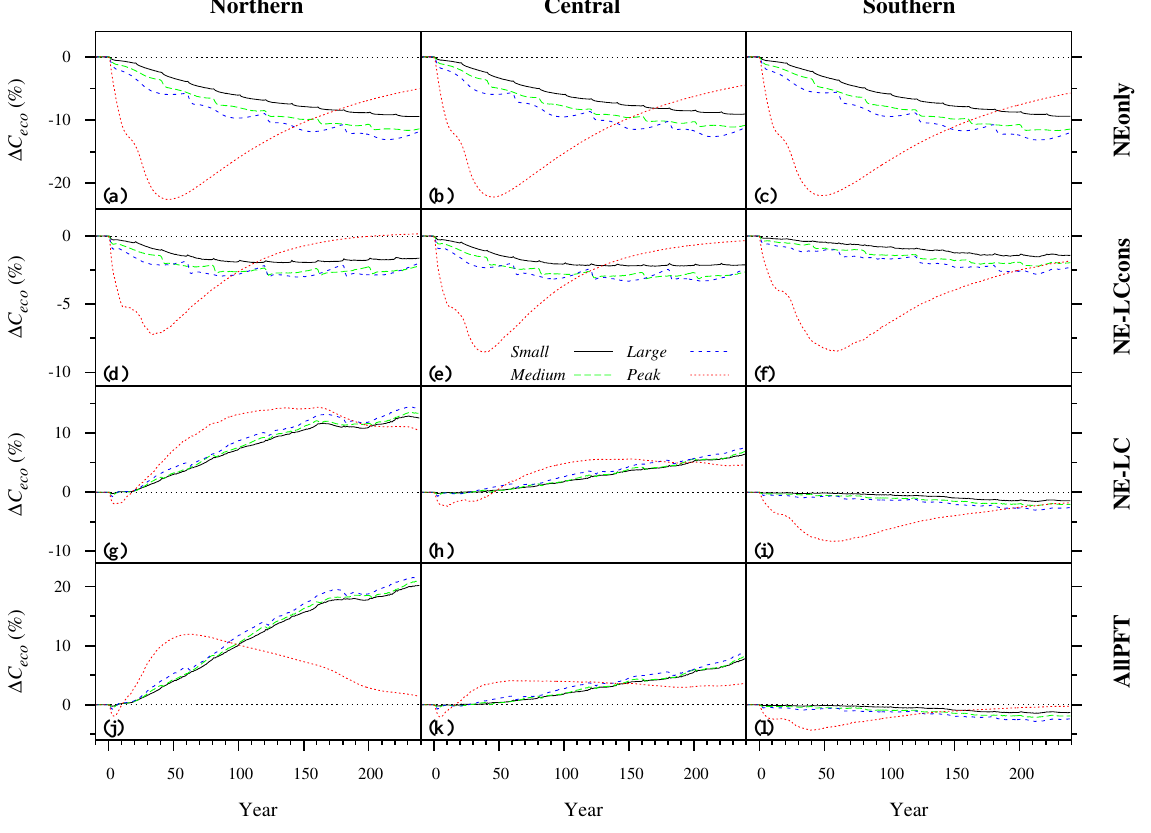
Figure 3. Transient effect of the different MPB outbreak regimes on ecosystem carbon ( C eco ) compared with the no-outbreak control run (first outbreak occurred in year 1). The columns correspond to the three locations (Fig. 1) and the rows to the four vegetation coexistence scenarios (Table 2); the y axis scale differs across the four rows. Control values differed among locations and vegetation coexistence scenarios, so the same relative change (in %) across the 12 panels does not correspond to the same absolute